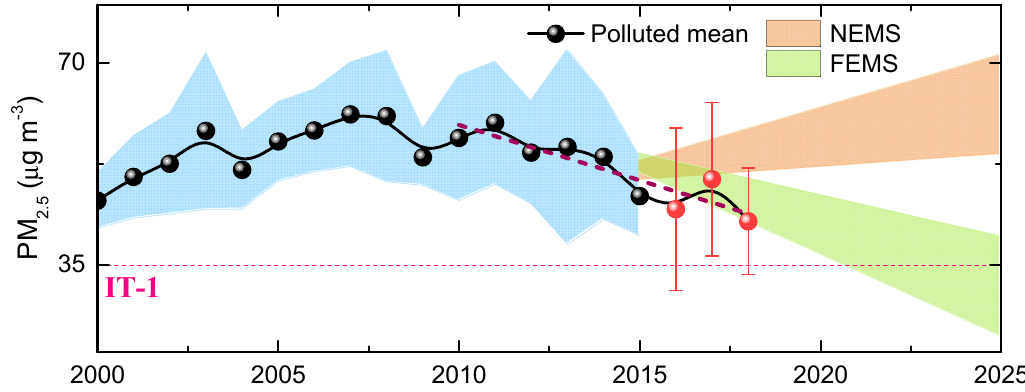
Figure 10. Satellite-derived annual mean PM 2.5 mass concentrations averaged over the five polluted areas for 2010 to 2015 (navy-blue points). These data were extrapolated to 2025 for two different emission control scenarios (NEMS and FEMS, with different meteorological factors), as described in the text. Red points are the annual mean PM 2.5 from ground-based measurements in 2016–2018 for comparison with the scenarios. The shaded area is slightly higher than the satellite-derived annual mean PM 2.5 for 2015 due to the superposition of anthropogenic and meteorological trend predictions for different periods during 2000 to 2015.